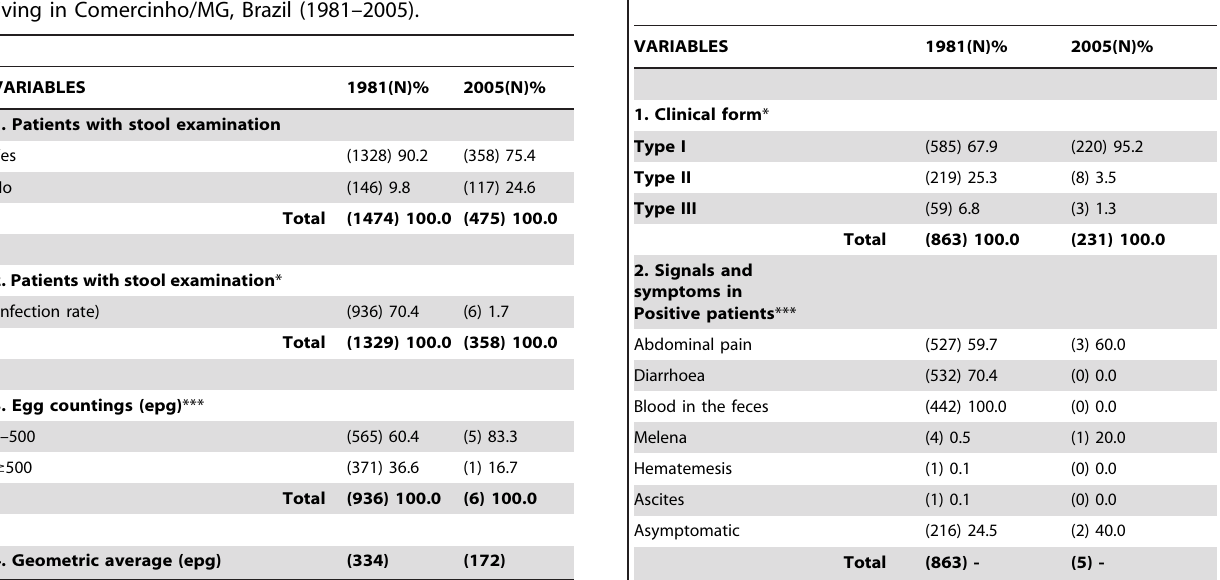
Table 3. Comparative data of the clinical re-evaluation in Comercinho/MG, Brazil